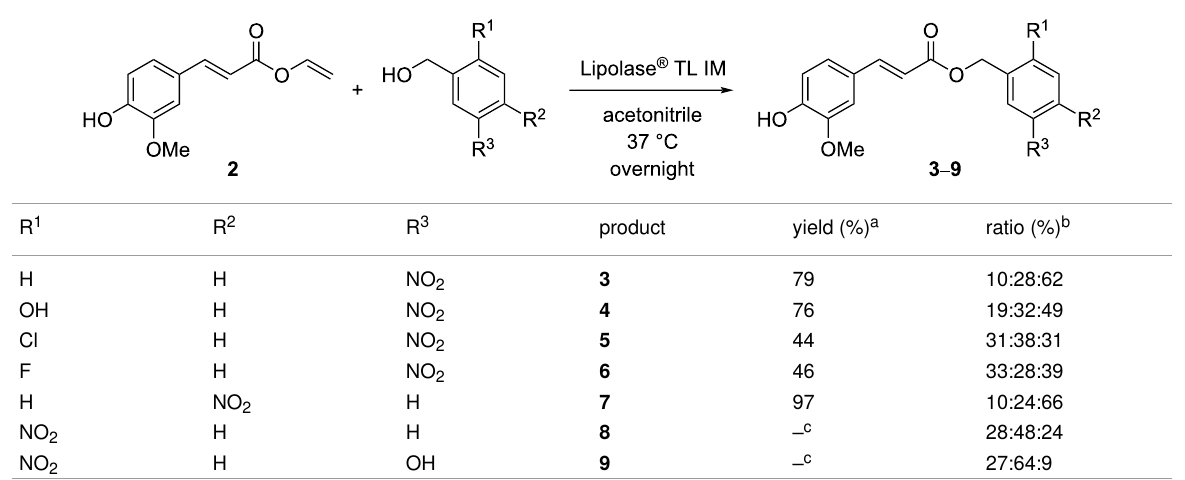
a Yield of isolated ferulates after the purification step. b Determined by 1 H NMR spectroscopy, ratio of the different feruloyl derivatives in the crude reac- tion mixture: remaining vinyl ferulate, ferulic acid (hydrolysis product), and the ferulates 3 – 9 . c The expected ferulates were confirmed by HRMS analy- sis, but the low purity of the samples after purification prevented a fine-structural characterization by NMR.